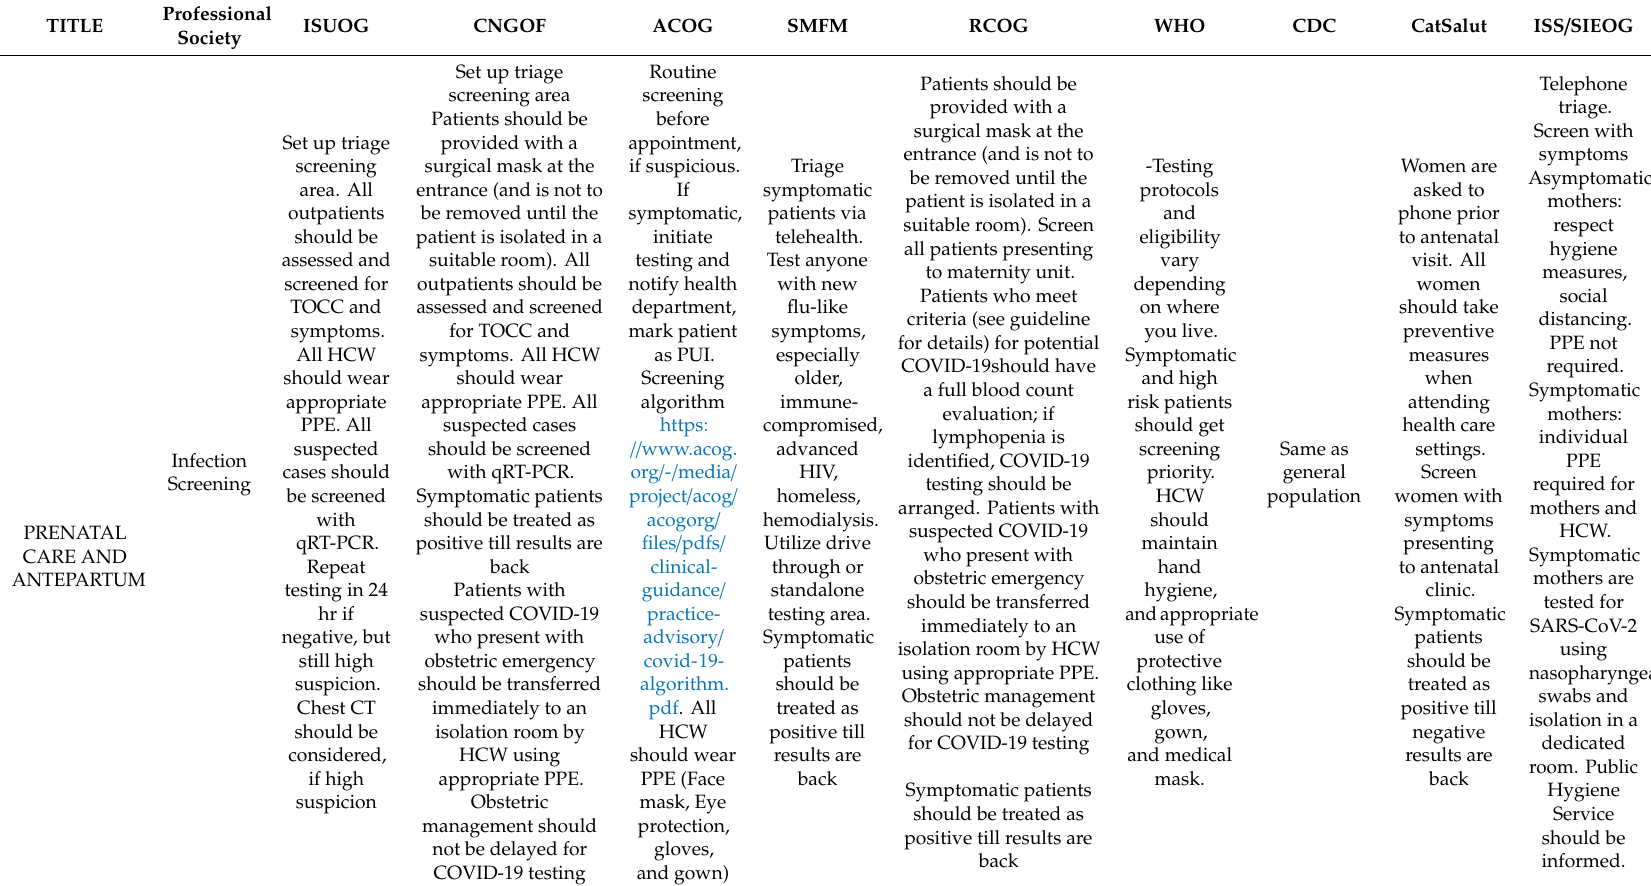
Table 2. Summary of guidelines for antepartum care of pregnant patients during the COVID-19